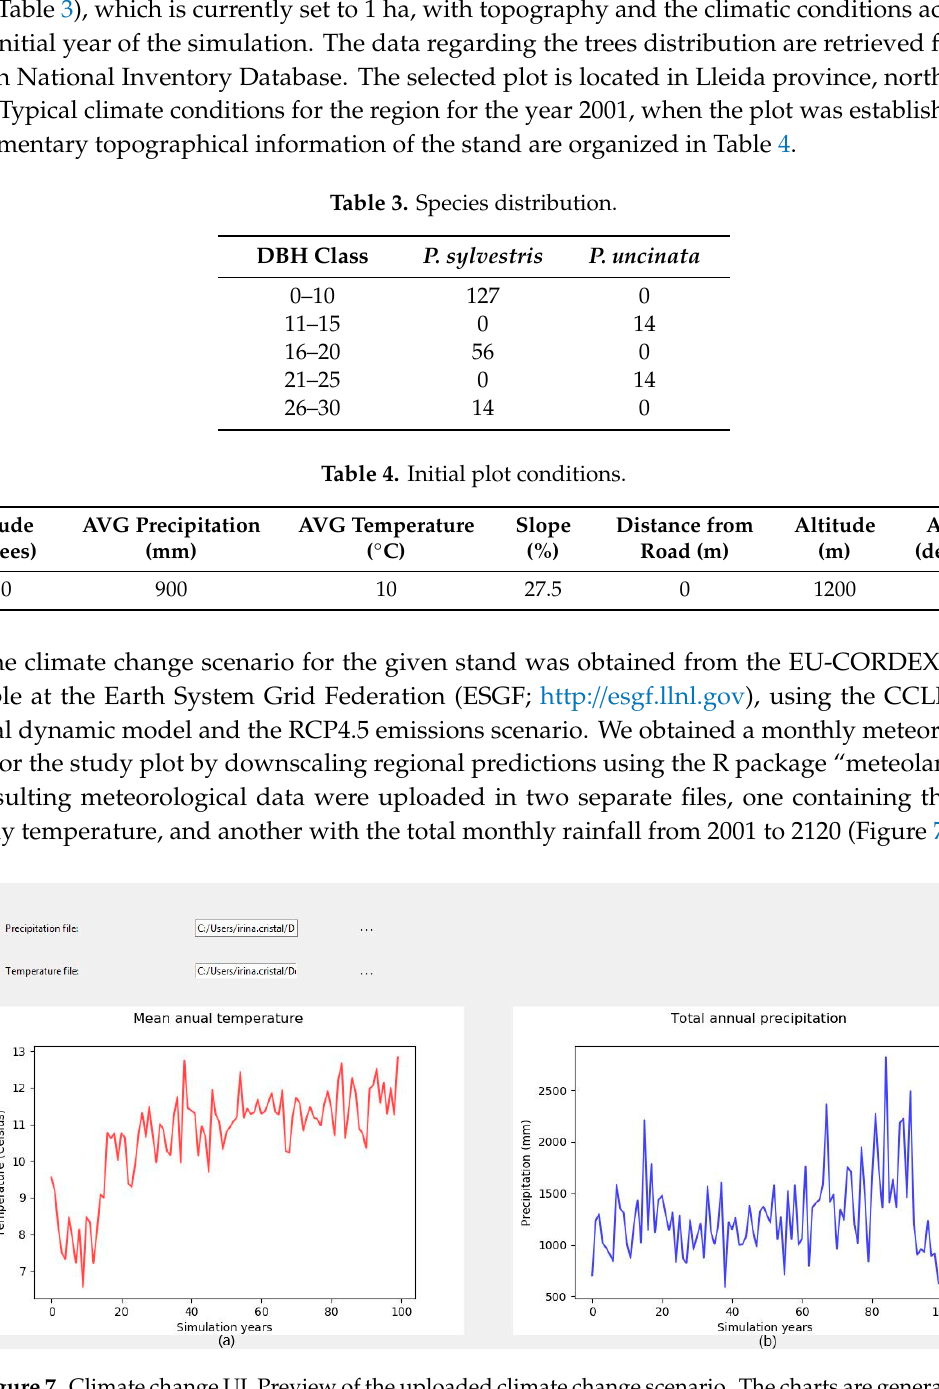
Figure 7. Climate change UI. Preview of the uploaded climate change scenario. The charts are generated by calculating the mean annual temperature ( a ) and total annual precipitation ( b ) throughout the simulated period from the uploaded